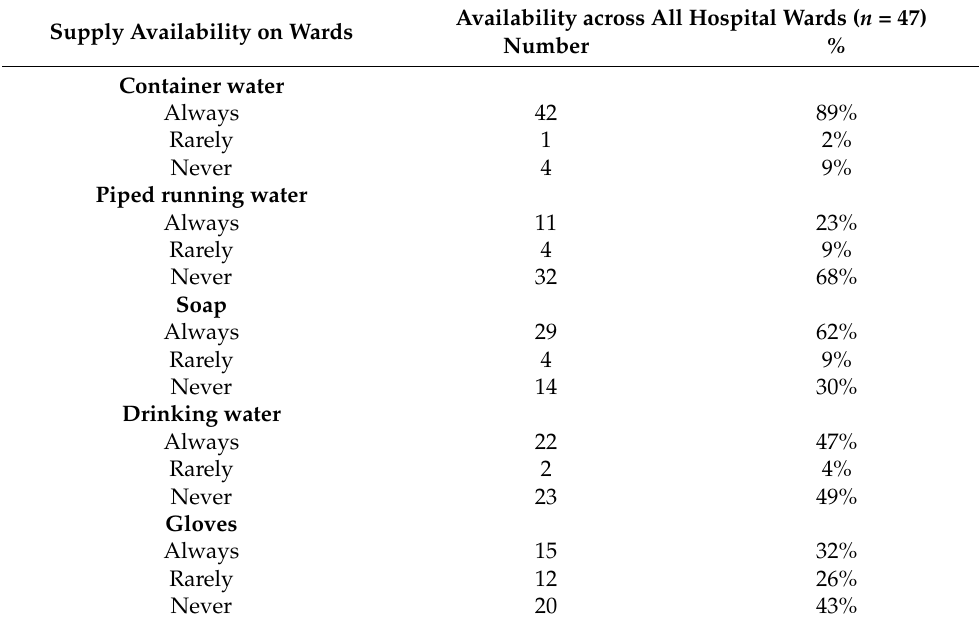
Table 2. Reported availability of hand hygiene supply on wards in 7 Liberian hospitals, 2020.